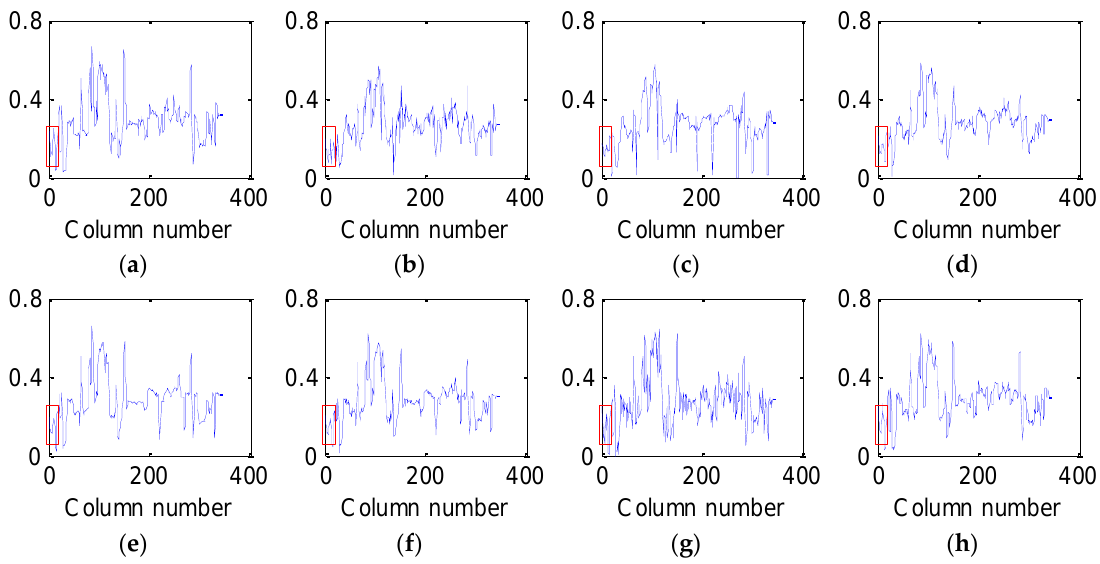
Figure 12. Horizontal profiles of band 90 at pixel (399, 290) before and after denoising:( a ) clean HSI; ( b ) KSVD; ( c ) BM3D; ( d ) ANLM3D; ( e ) BM4D; ( f ) LRMR; ( g ) DDL3+FT; ( h ) Our method.